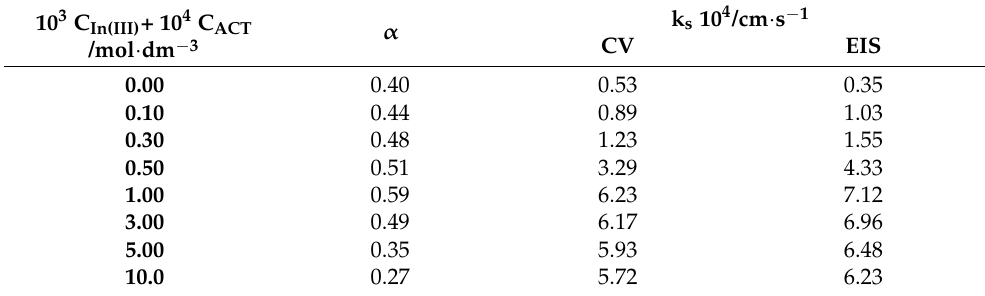
Table 5. The values of cathodic transition coefficients ( α ), standard rate constants determined by the voltammetry ( k s ) and impedance ( k f ) methods of 1 × 10 − 3 mol · dm − 3 In(III) ions electroreduction in 1 mol · dm − 3 chlorates(VII) and in the presence of acetazolamide.